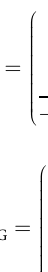
wave is normally launched with a polarization aligned along the direction − 45 degrees to the grating wire. Due to the polarization conversion effect of the grounded-grating structure, the reflected wave has two polarization components, with one being co-polarized (marked by the blue arrow and with a reflection efficiency denoted by r co ) and the other being cross-polarized (marked by the red arrow and with a reflection efficiency denoted by r cx ). The corresponding signal-flow chart is sketched by the right part of Fig. 6(a), where the signal-flow paths colored by blue and red denote the polarization channels which are co-polarized and cross-polarized respectively. The virtual mirror denoted by M G is in correspondence to the grounded-grating structure. It plays the role of signal coupling between the blue and red channels. Figure 6(b) describes the situation where the semi-infinite dielectric medium reduces to a dielectric slab and the metal grating is place at the central plane of the dielectric slab. In this situation, due to the reflection effect at the dielectric-air interface, two virtual mirrors marked by M D1 and M D2 are introduced. The signal-flow chart drawn by the right part of Fig. 6(b) can be transformed to the one drawn by Fig. 6(c), where the transmission and reflection efficiencies denoted by r ∞ and r cx represent the amplitude efficiencies of the co-polarized and cross-polarized components of the reflected beam respectively. They can be analytically obtained with the help of the method of transmission matrix. To this end, note that the transmission matrix of M D1 , M G and M D2 read as